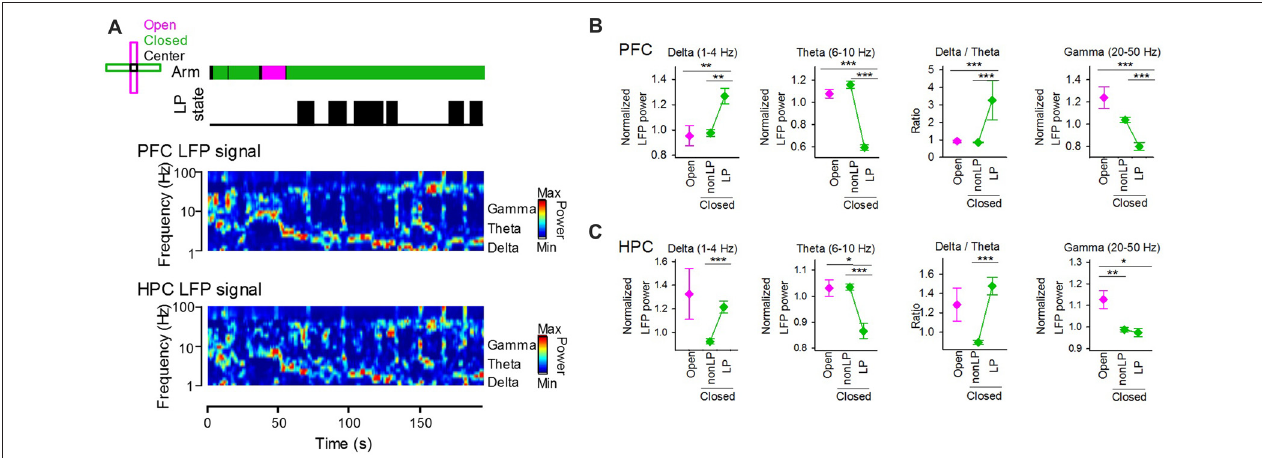
FIGURE 4 | (A) (From top to bottom) Arms wherein the animal was located, periods of LP states and LFP signals from the hippocampus and frontal cortex. The color-coded power spectrum constructed from the LFP signals. (B) Average powers of PFC LFP signals at the delta, theta and gamma bands in periods in which the animals were located in open and closed arms. The closed arms were further divided into two periods with and without LP states (LP and non-LP, respectively). At each frequency band, the LFP power was normalized by that averaged over the entire period of each recording session. The right panel shows the ratio of delta power to theta power. ∗∗ P < 0.01, ∗∗∗ P < 0.001, Wilcoxon signed-rank test with Bonferroni correction. (C) Hippocampal LFP signals at individual frequency bands. Like in (B) , data for the hippocampal LFP delta, theta, gamma powers are plotted. ∗ P < 0.05, ∗∗ P < 0.01, ∗∗∗ P < 0.001, Wilcoxon signed-rank test with Bonferroni